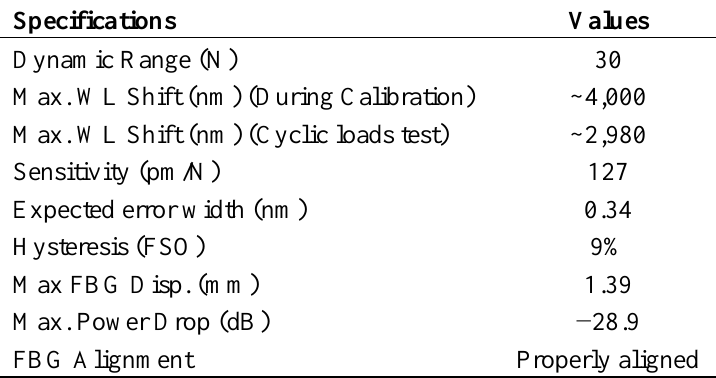
Table 1. FBG sensor specifications.